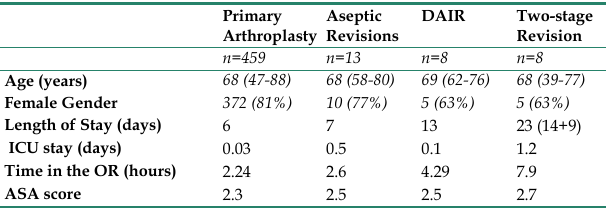
Table 1. Basic demographic and clinical data for 488 TKA patients